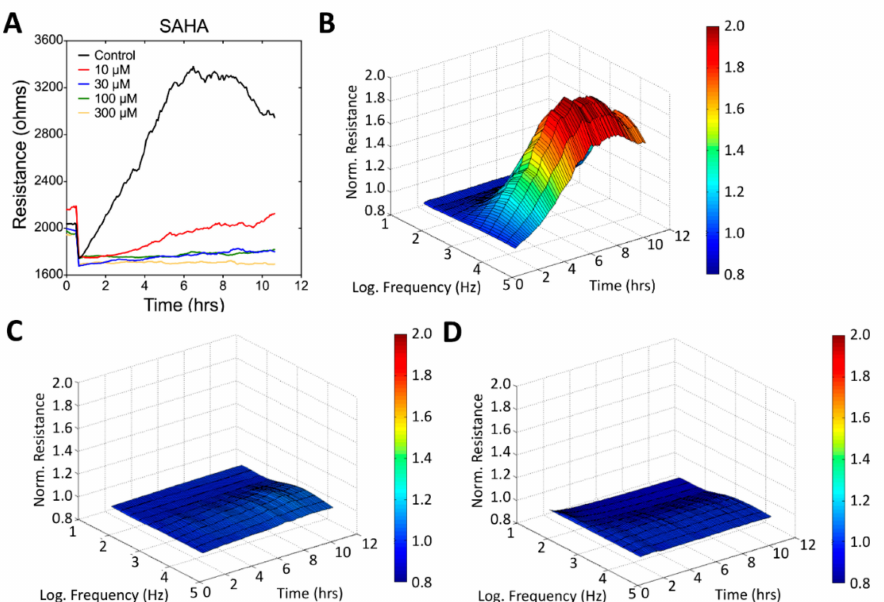
Figure 6. E ff ects of SAHA on the wound healing and migration of U-87 MG cells measured using ECIS. ( A ) Time course of the measured resistance at 4 kHz; three-dimensional demonstration of the e ff ects of SAHA at concentrations of ( B ) 0 µ M (control), ( C ) 30 µ M, and ( D ) 300 µ M on cell migration.